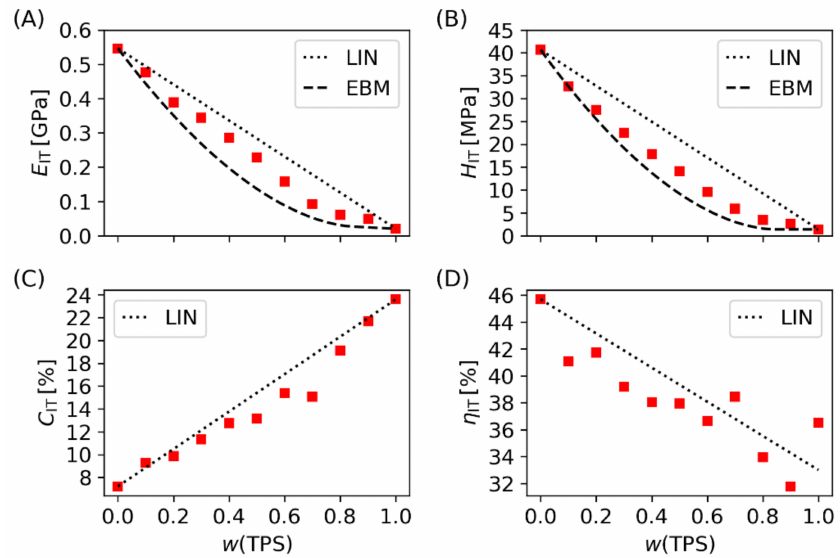
Figure 6. Micromechanical properties of TPS, PCL, and of the TPS/PCL blends (red points) vs. theoretical predictions (black lines). The plots show ( A ) indentation hardness, ( B ) indentation modulus, ( C ) indentation creep and ( D ) elastic work of indentation. The theoretical predictions comprise linear model (LIN; the final blend property is a linear combination of the blend component properties) and equivalent box model (EBM; a simple predictive scheme for isotropic polymer blends, which considers phase continuity and interfacial adhesion). The models are described in Section 3.2.1.